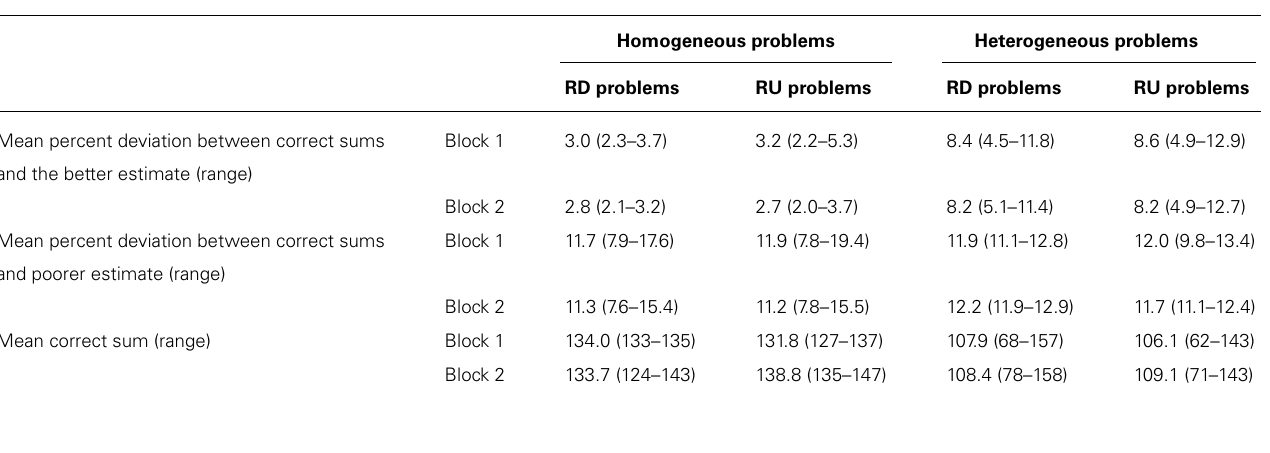
Table 1 | Stimuli